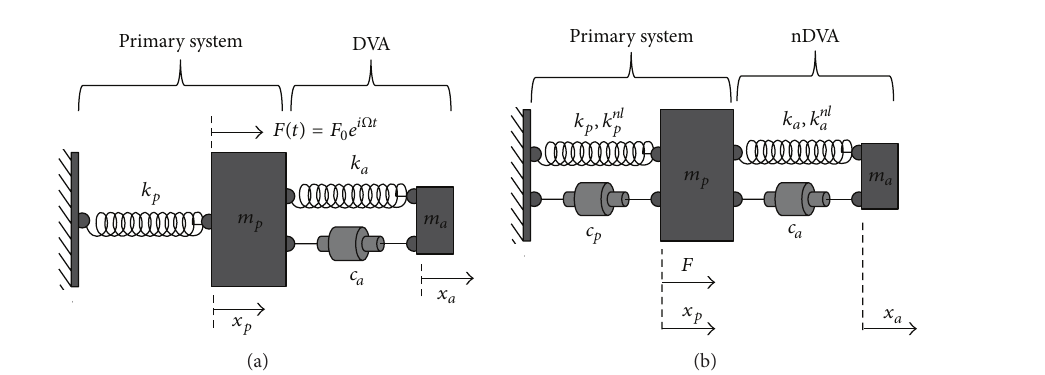
Figure 8: Linear (DVA) and nonlinear (nDVA) dynamic vibration absorbers.